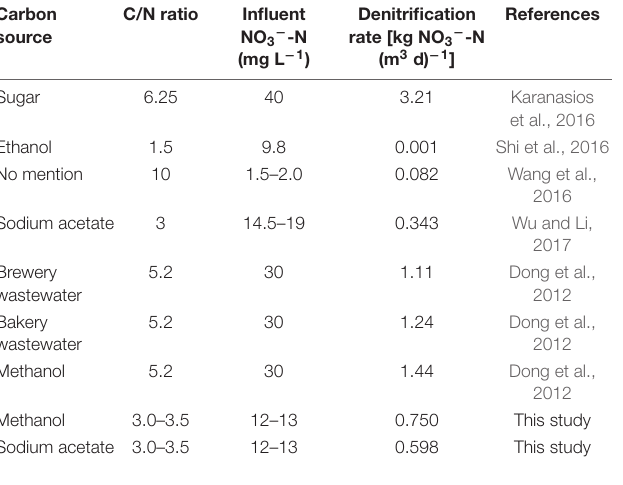
TABLE 3 | Performance comparisons with other bioreactor configurations.